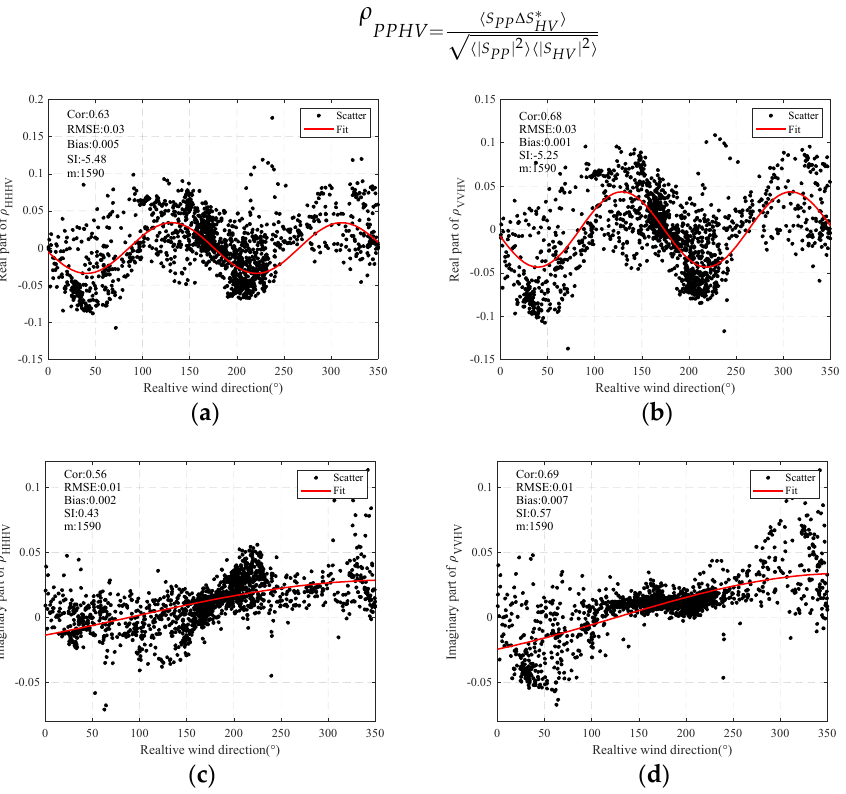
Figure 13. Performance of polarization correlation coefficient ρ variation relative to relative wind direction: ( a ) Real part of ρ HHHV ; ( b ) Real part of ρ VVHV ; ( c ) Imaginary part of ρ HHHV ; ( d ) Imaginary part of ρ VVHV